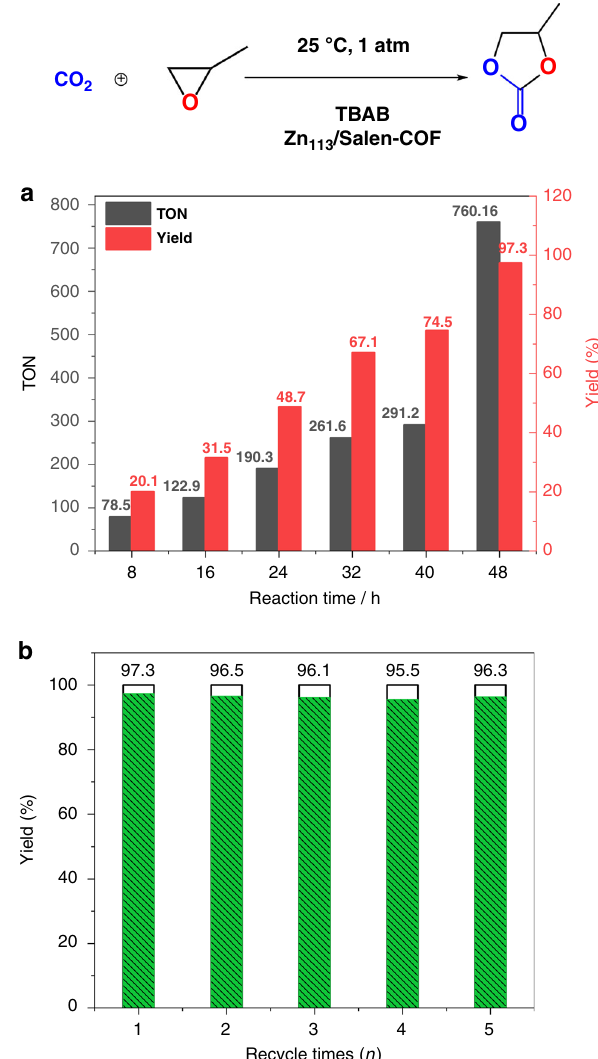
Fig. 5 Catalytic performance for Zn-Salen-COF-SDU113. a The yield of PC depending on the reaction time and b recycling stability of Zn-Salen-COF- SDU113 at atmospheric pressure and room